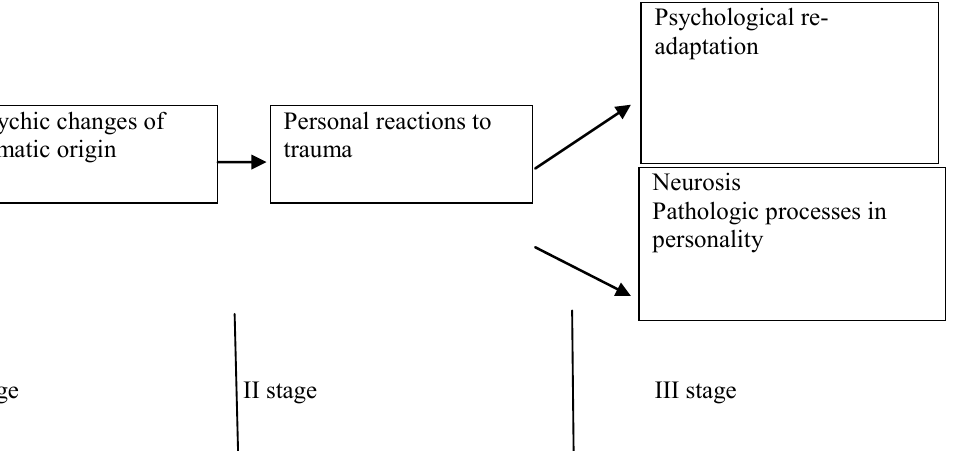
Fig.1. Psychological changes at different stages of traumatic disease (I stage – 1 st week, II stage – first 3 weeks, III stage – tardy period of disease) by V.A. Yepifanov,